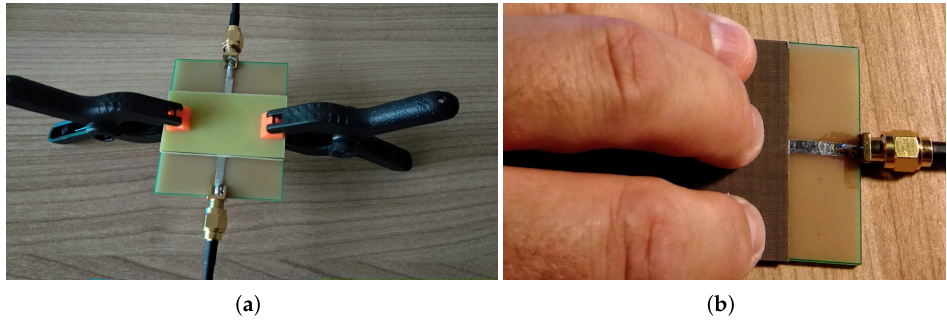
Figure 7. Measurements on FR4 with clamps and TLX8 with fingers. ( a ) measurement of FR4. ( b ) measurement of